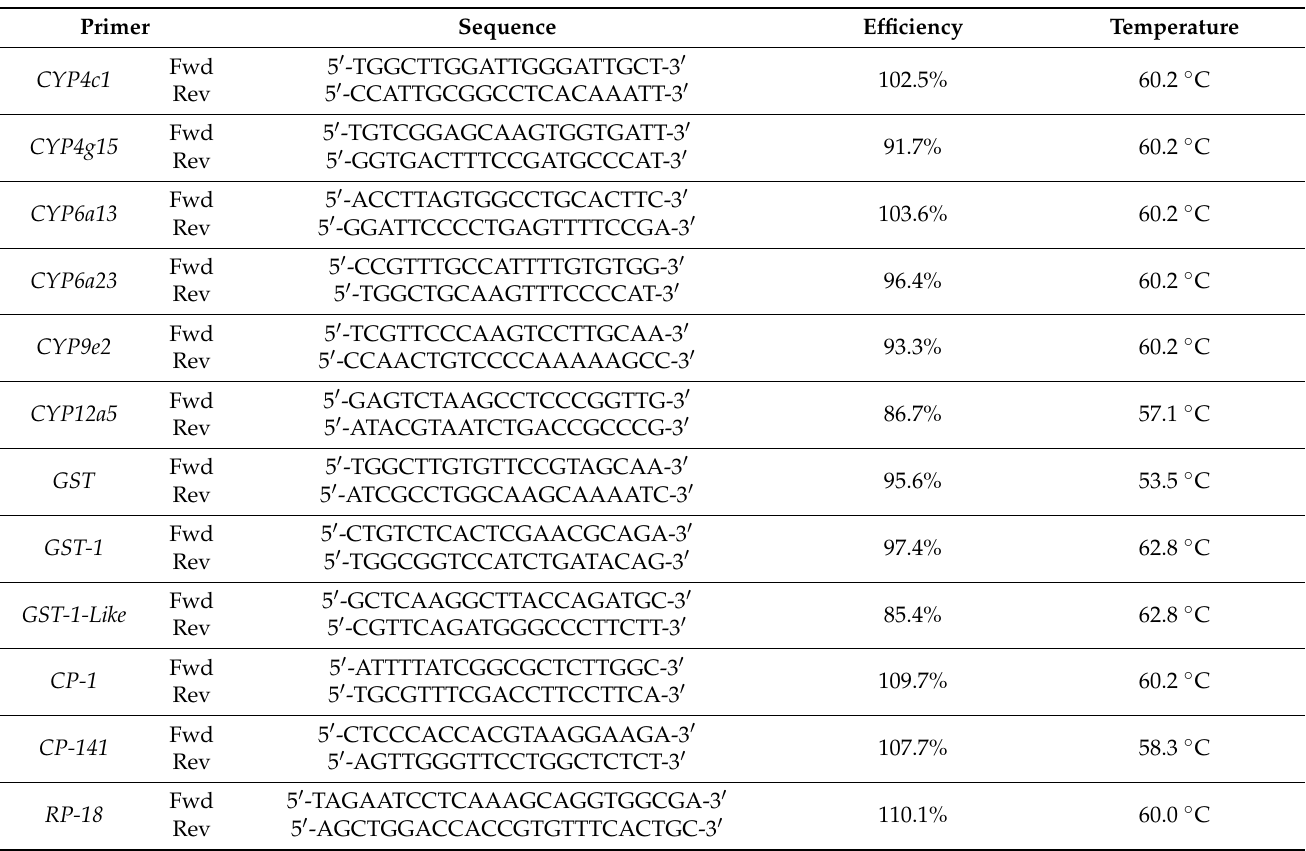
Table 1. Primers used for quantification by qRT-PCR of relevant transcripts. Abbreviations: Forward (Fwd) and Reverse (Rev)